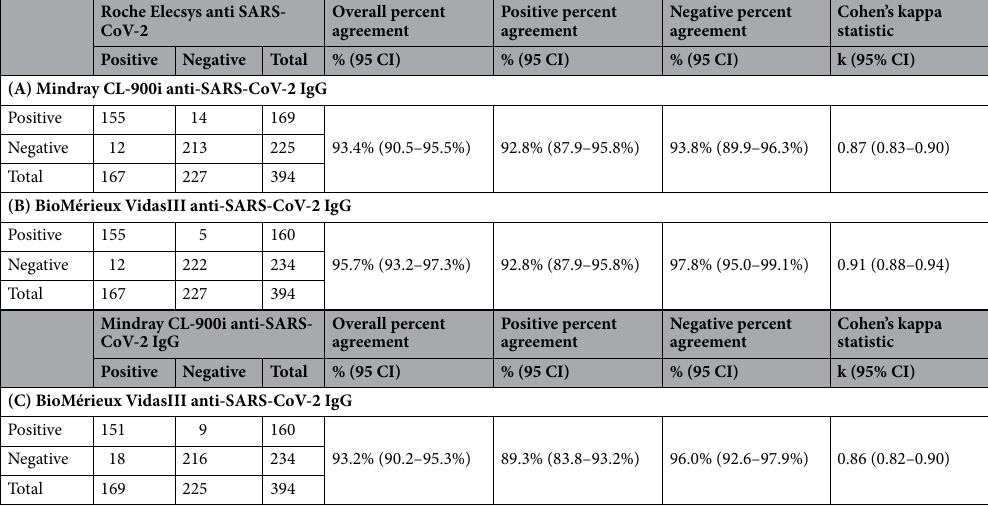
Table 2. Concordance metrics between (A) the Mindray CL-900i anti-SARS-CoV-2 IgG testing and the Roche Elecsys Anti SARS-CoV-2 testing, (B) the VidasIII anti-SARS-CoV-2 IgG testing and the Roche Elecsys Anti SARS-CoV-2 testing, and (C) the BioMérieux VidasIII anti-SARS-CoV-2 IgG testing and the Mindray CL-900i anti-SARS-CoV-2 IgG testing. CI confidence